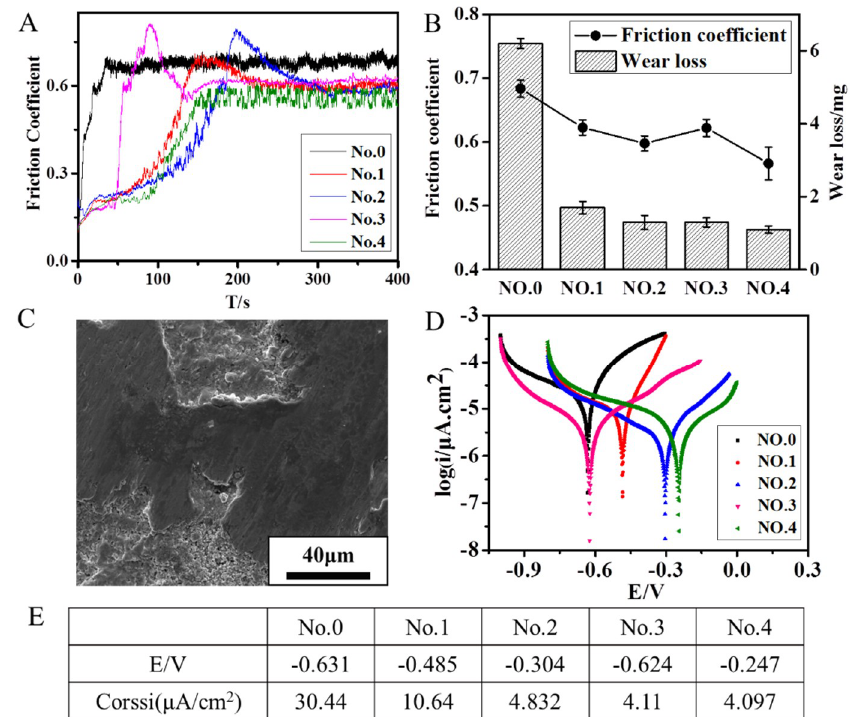
Figure 7. The friction–wear and corrosion tests of the coatings (No.0–No.4 refer to the Ni and Ni/CNTs@pDA-6, 12, 18, and 24 h coatings). ( A ) The image of the friction coefficient curve of several coatings. ( B ) The image of the friction coefficient and wear loss of several coatings. ( C ) The SEM image of the worn scar of the PDA@CNTs/Ni composite coatings. ( D ) The polarization curve of several coatings acquired by electrochemical detection. ( E ) The corrosion current density of the coatings obtained by fitting the polarization curve.